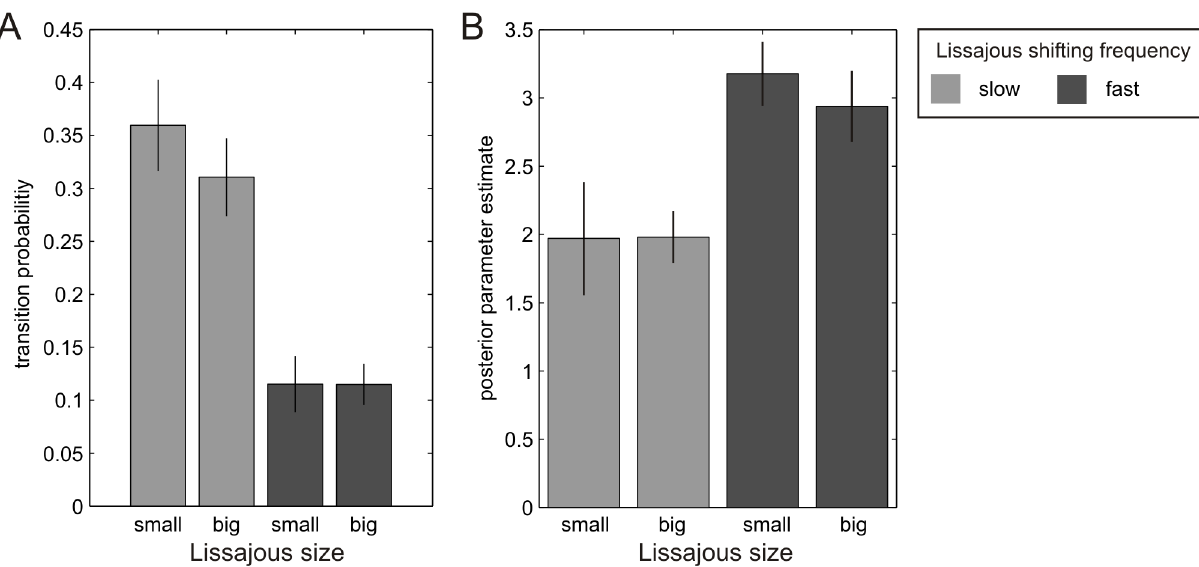
Fig 4. Results of the standard and Bayesian data analysis. (A) Average transition probabilities separately for the four conditions, averaged across runs and participants. Error bars indicate the standard error of the mean. (B) Posterior parameter estimates for π init . Posterior parameters averaged across runs and participants, separately for all